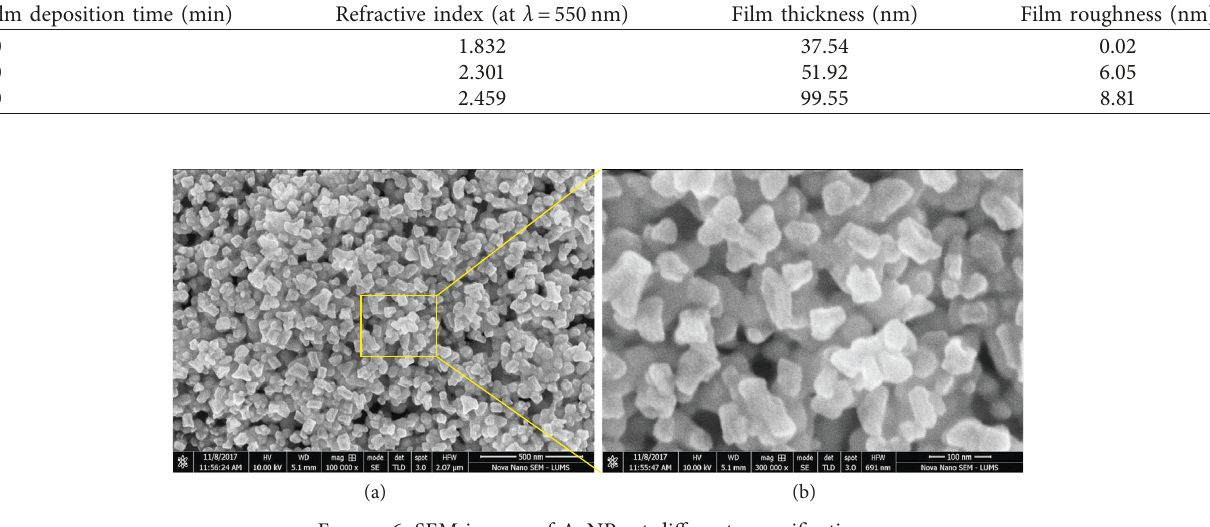
Figure 6: SEM images of AgNPs at different